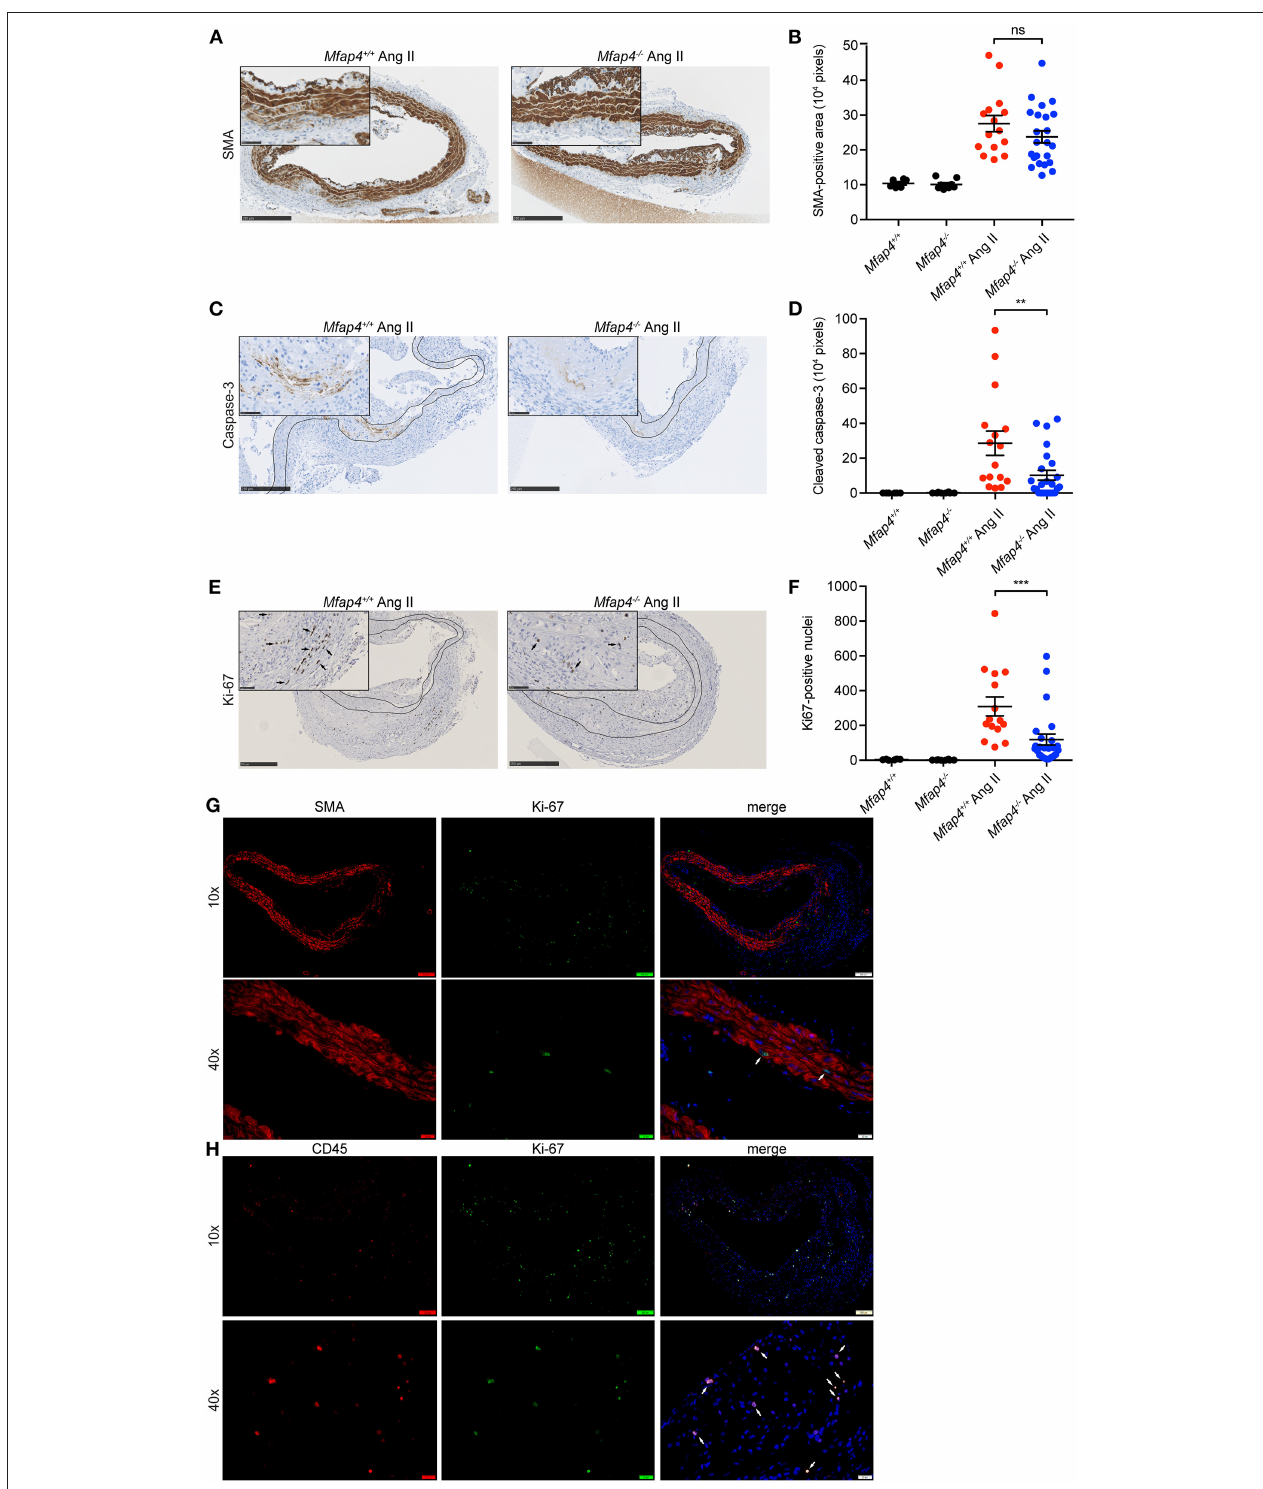
FIGURE 4 | Mfap4 deficiency reduces cellular proliferation and apoptosis in Ang II-induced AAAs. Morphometric analysis of (A,B) α -smooth muscle actin (SMA), (C,D) cleaved caspase-3, and (E,F) Ki-67 stainings of aortic sections of ApoE − / − ( Mfap4 + / + ) and ApoE − / − Mfap4 − / − ( Mfap4 − / − ) mice after 28 days of Ang II infusion. Black arrows indicate examples of positive cells. Black lines delineate borders between intimal, medial and adventitial layers. (G,H) Double immunofluorescent staining of Ki-67 and SMA (G) or CD45 (H) . White arrows indicate examples of double-positive cells. n = 6–8 (saline), 15–26 (Ang II). Representative pictures are shown. Scale bar = 250 µ m/50 µ m (A,C,E) , 100 µ m/20 µ m (G,H) . ** p < 0.01, *** p < 0.001, analyzed with Mann-Whitney U -test. ns, non-significant.